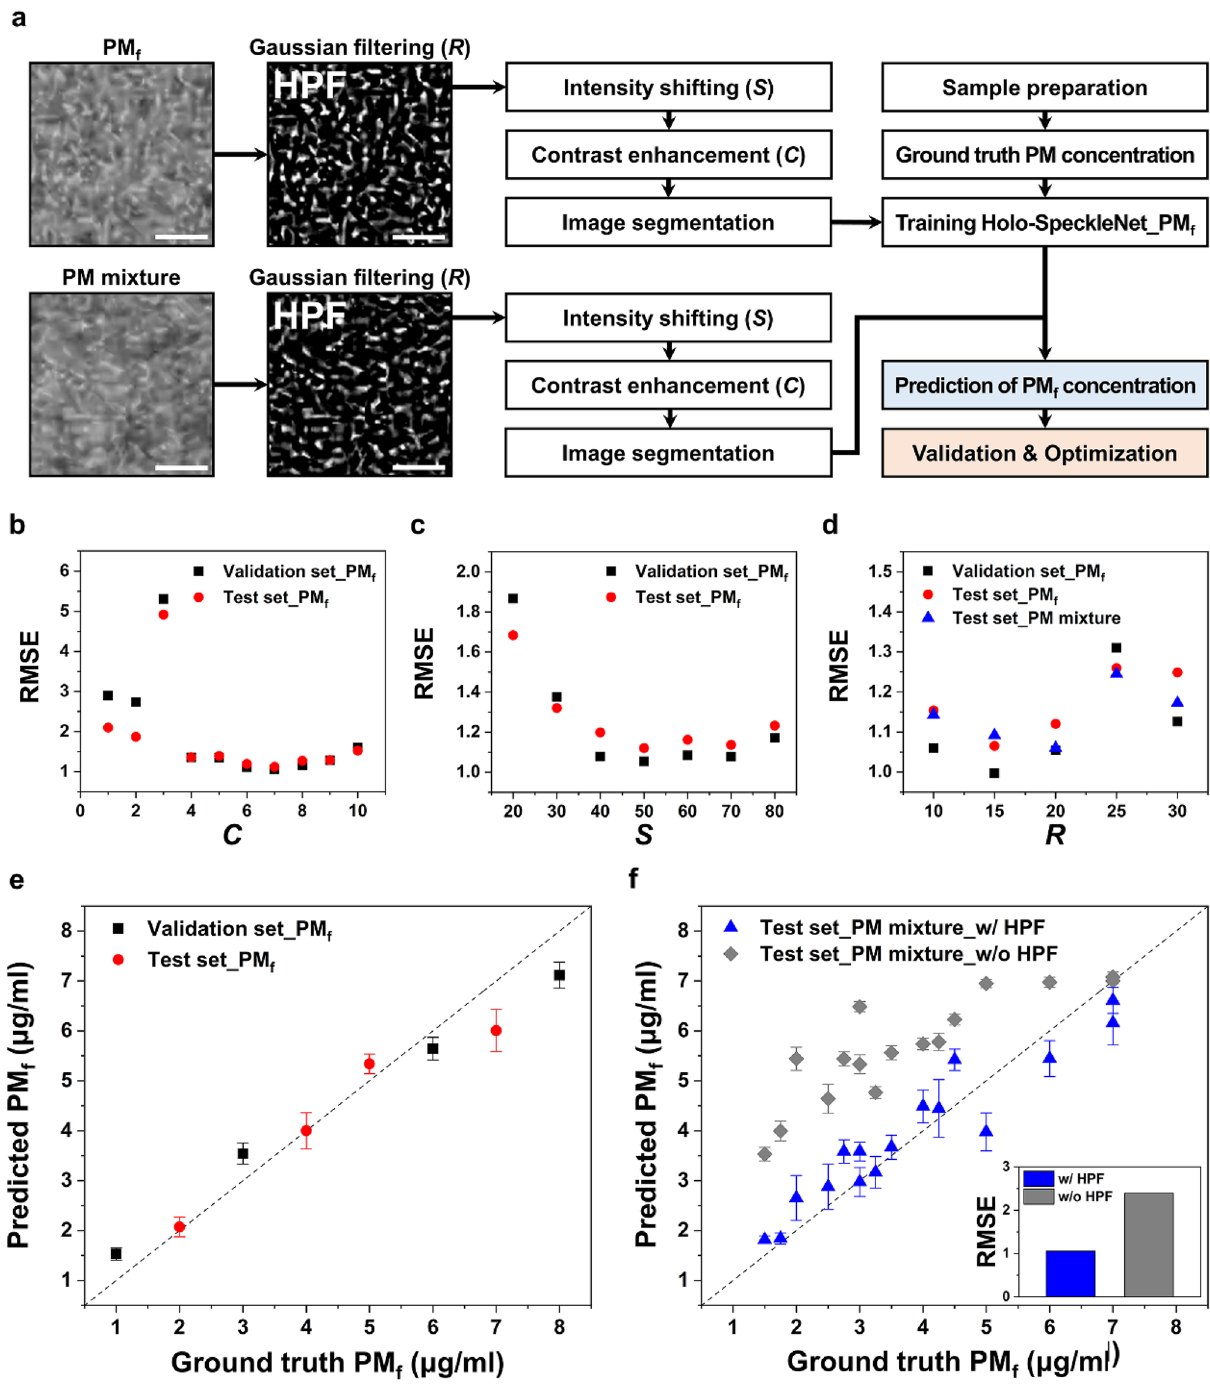
Figure 4. Smartphone-based measurement of PM f concentrations. ( a ) Overall workflow used to predict PM f concentrations. PM concentration labels of segment images: (PM f ) ρ f = 8 µg/ml; (PM mixture) ρ f , ρ c = 6 µg/ml. Optimization of hyperparameters associated with digital image processing: RMSE variations according to ( b ) contrast enhancement parameter C , ( c ) intensity shifting parameter S , and ( d ) Gaussian filter size R . Predicted PM f concentrations of ( e ) monodisperse PM f and ( f ) polydisperse PM mixture samples. Scale bars are 10